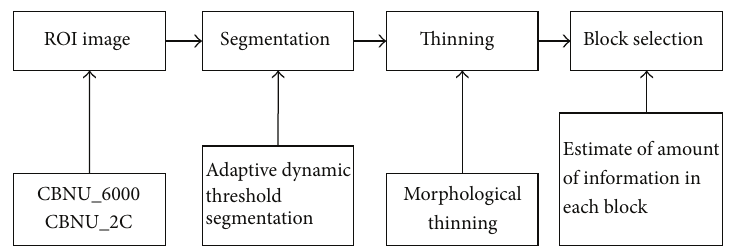
Figure 6: Block selection using estimate of the amount of information in each block.